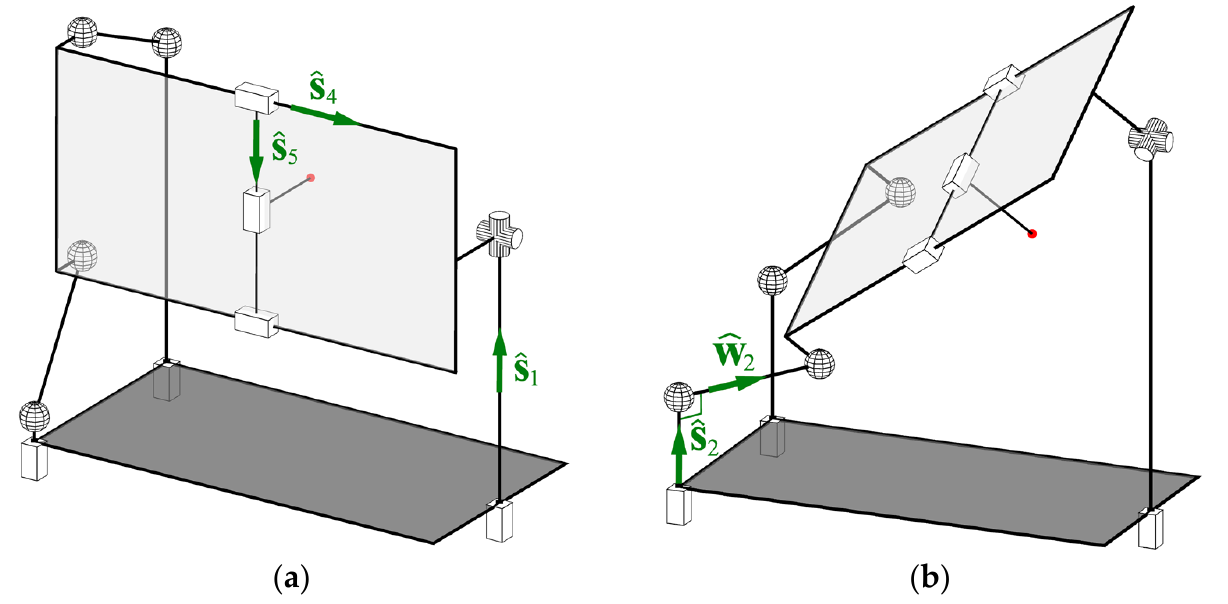
Figure 7. Serial singularities: ( a ) parallelepiped formed by vectors ˆ s is othogonal to ˆ s 2